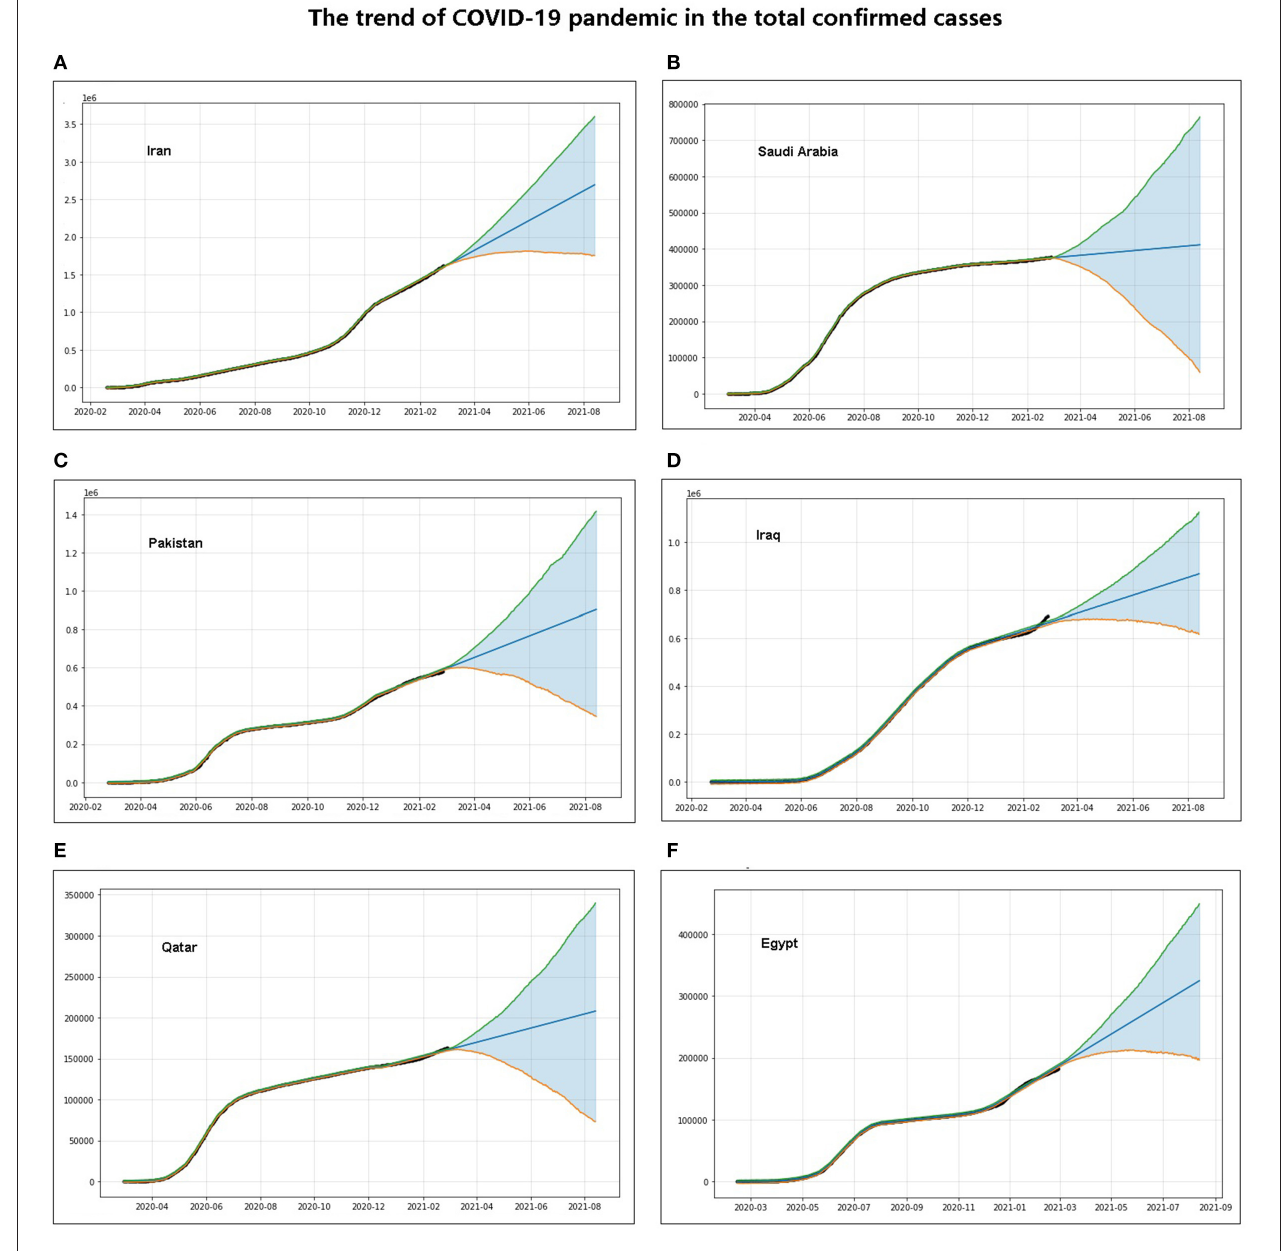
FIGURE 4 | Forecast of overall trends in the coronavirus disease 2019 (COVID-19) pandemic: (A–F) trends of the number of total COVID-19 confirmed cases forecast by machine-learning methods in Iran, Saudi Arabia, Pakistan, Iraq, Qatar, and Egypt,